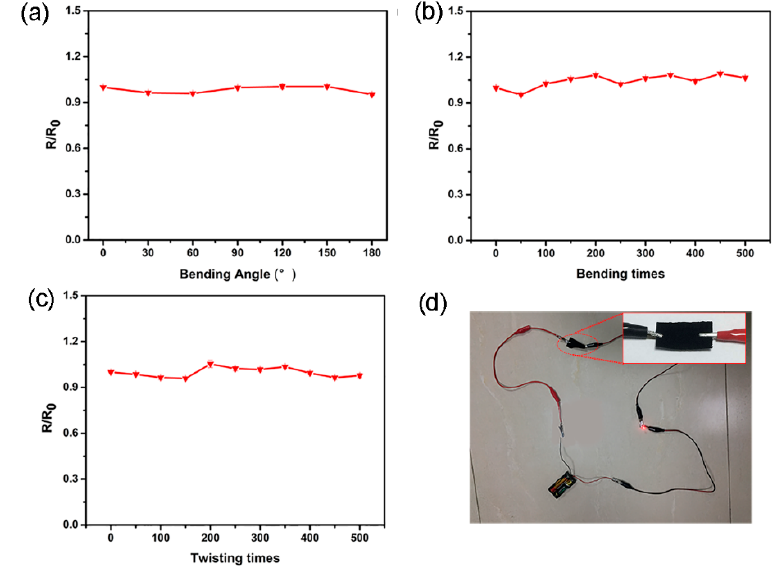
Figure 4. ( a ) The normalized resistance of PPy-coated polyester/spandex textile at the bending angle of 0–180°; effects of repeated bending ( b ) and twisting ( c ) on the normalized resistance of PPy-coated polyester/spandex textiles; and ( d ) demonstration of the conductivity of PPy-coated polyester/spandex textile.